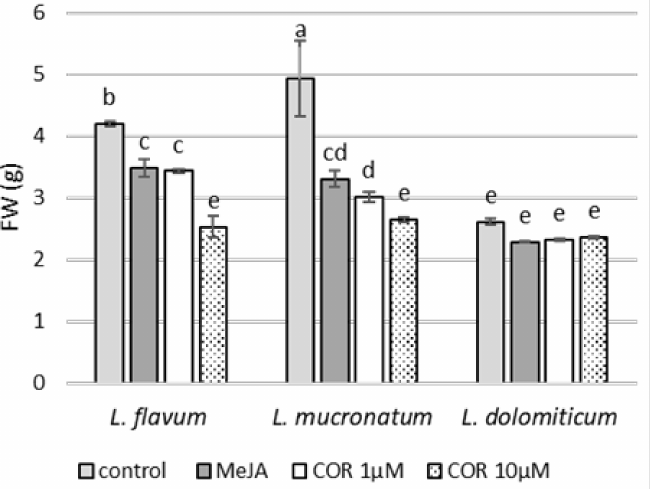
Figure 2. Effect of elicitors on the growth of ARc of L. flavum , L. mucronatum and L. dolomiticum over a cultivation period of 25 days in MS-II liquid medium expressed as fresh weight (FW) in grams; control (light gray), MeJA (100 µ M, dark gray), COR 1 µ M (white), COR 10 µ M (dotted). Each value is the mean of three biological replicates ± SD. The samples with different letters are significantly different at p ≤ 0.05 according to Duncan test. The growth index of each ARc culture is reported from left to right; L. flavum : 4.2, 3.4, 3.3, 2.2; L. mucronatum : 5.2, 3.1, 2.8, 2.3; L. dolomiticum : 2.3, 1.9, 1.9,